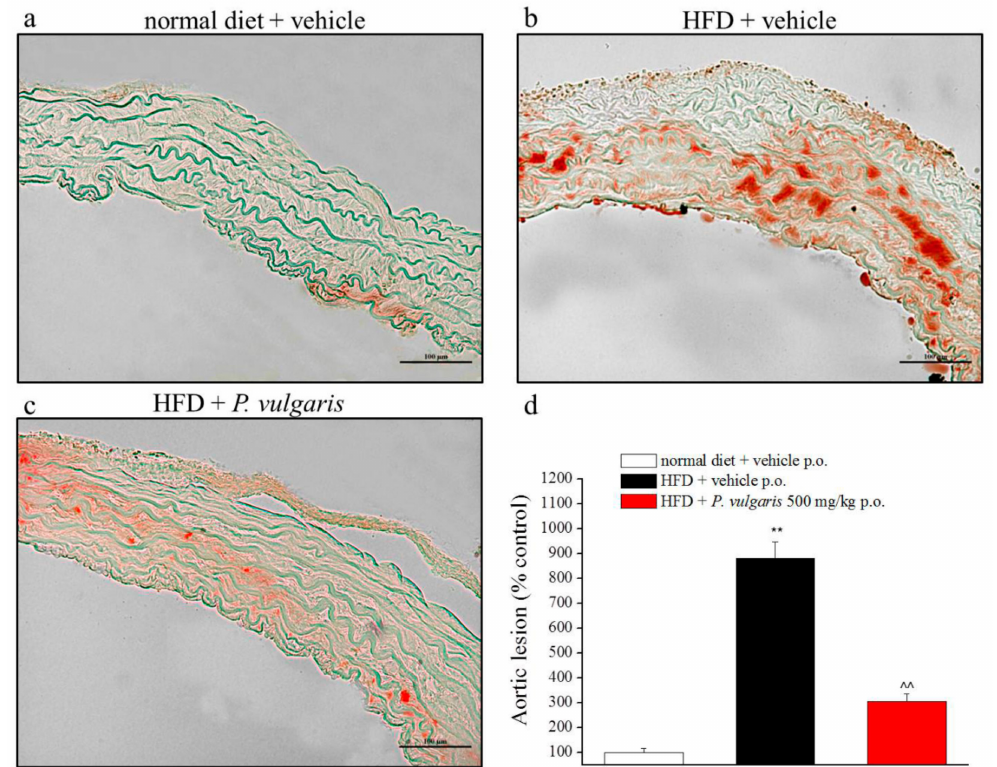
Figure 8. Vascular damage. ( a – d ) Evaluation of fatty streak infiltrations in aortic tissue of animals an week 19. ( a , b , d ) Representative images of aortic arch sections stained with Oil-Red O, 20X magnificated. ( d ) Quantitative determination of lesion extension, calculated as the positive area in comparison to the total cross-sectional vessel wall area. Aortic damage is expressed as percentage in comparison to control samples (set as 100%). ** p < 0.01 vs. normal diet + vehicle; ˆˆ p < 0.01 vs. HFD +